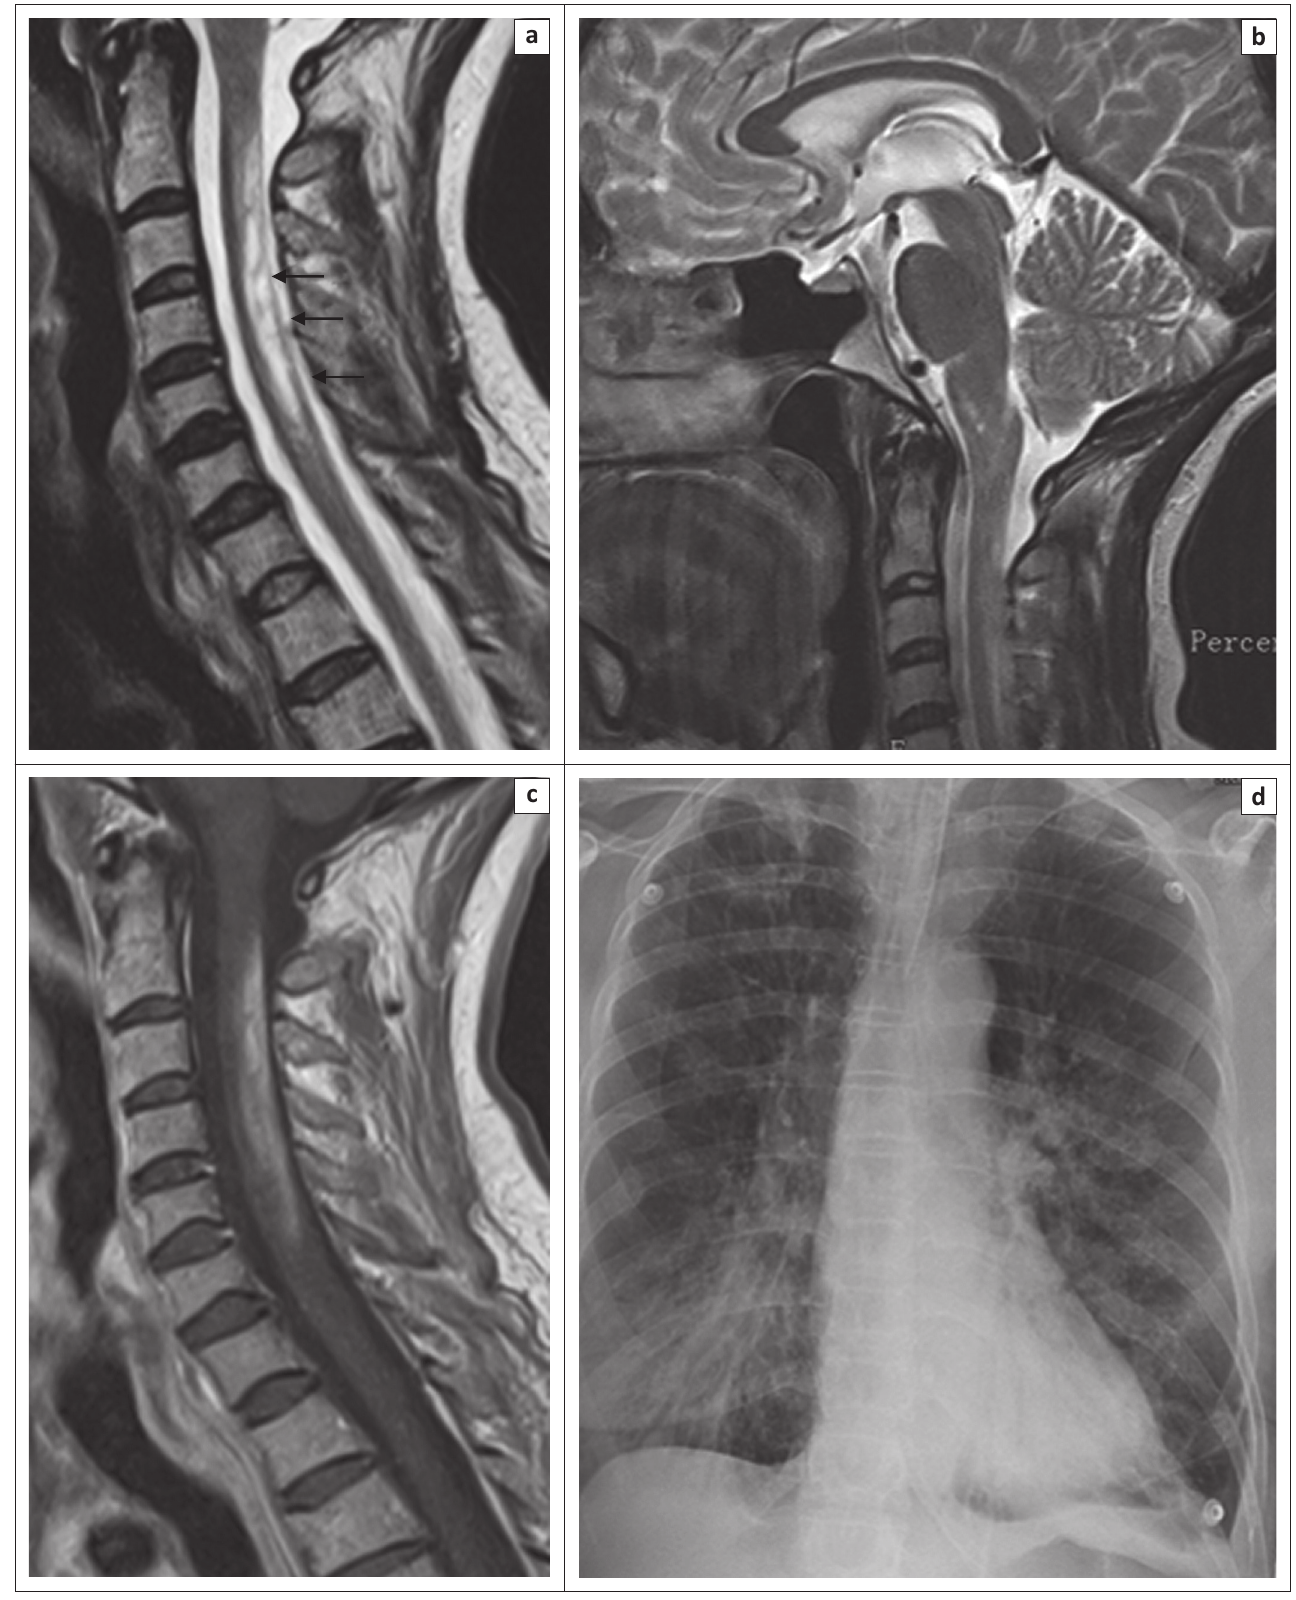
FIGURE 1: (a) and (b) are T2 sagittal images showing high intensity signal in the lower medulla and upper cervical cord; (c) is post-contrast T1 image showing enhancement of the lesion; (d) is a chest radiograph showing features consistent with